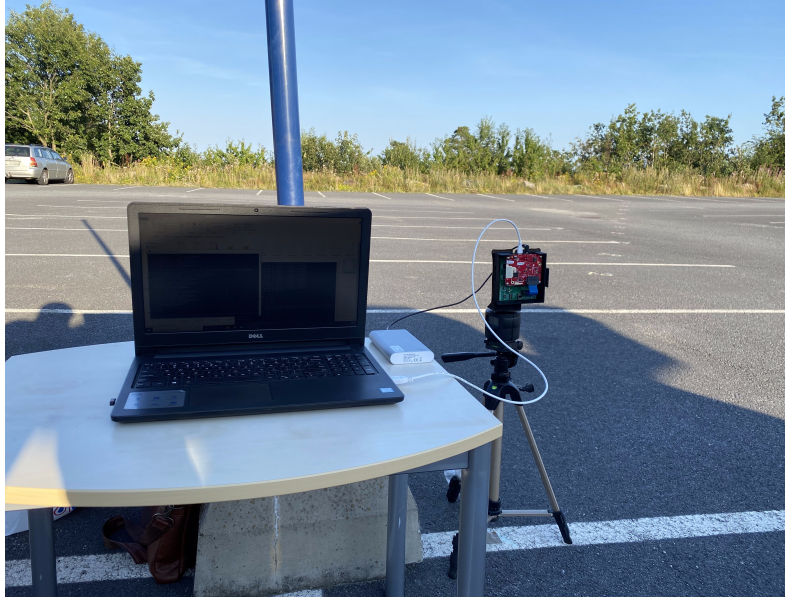
Figure 2. The mmWave radar measurement setup. Table 2. Measurement cases (range in meters and angle in